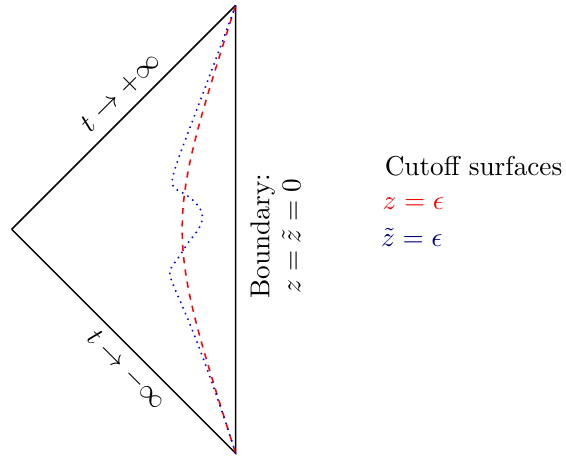
Figure 2 . A conformal diagram of the Poincar(cid:19)e-patch of AdS 3 . The vertical line is the asymptotic boundary while the two diagonal lines are the two Poincar(cid:19)e-horizons where t ! (cid:6)1 . The two cuto(cid:11) surfaces z = (cid:15) and ~ z = (cid:15) are shown as dashed (red) and dotted (blue) lines, respectively. The (cid:12)gure is taken from